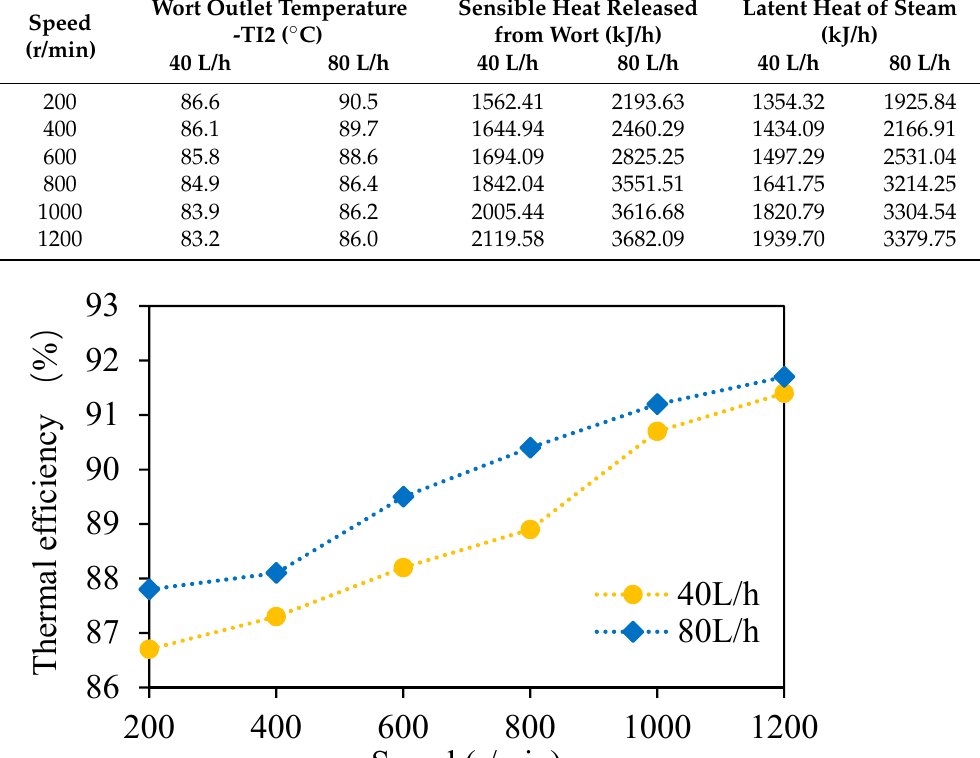
Table 2. Changes in the wort outlet temperature and energy consumption.